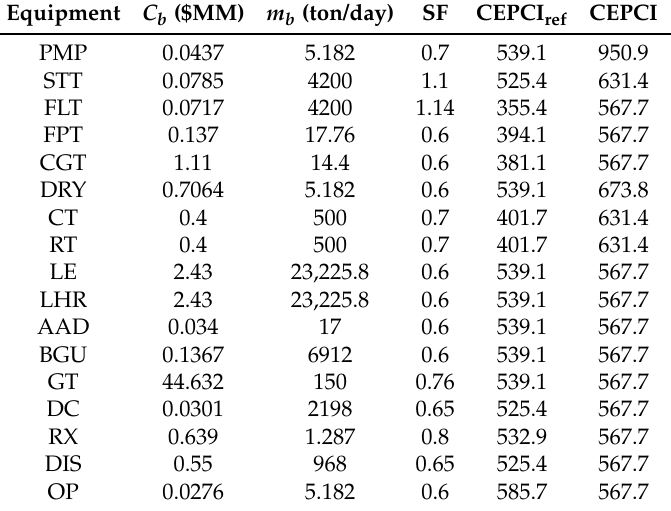
Table 1. Parameters used to estimate the purchase cost of all the equipment in the superstructure shown in Figure 1